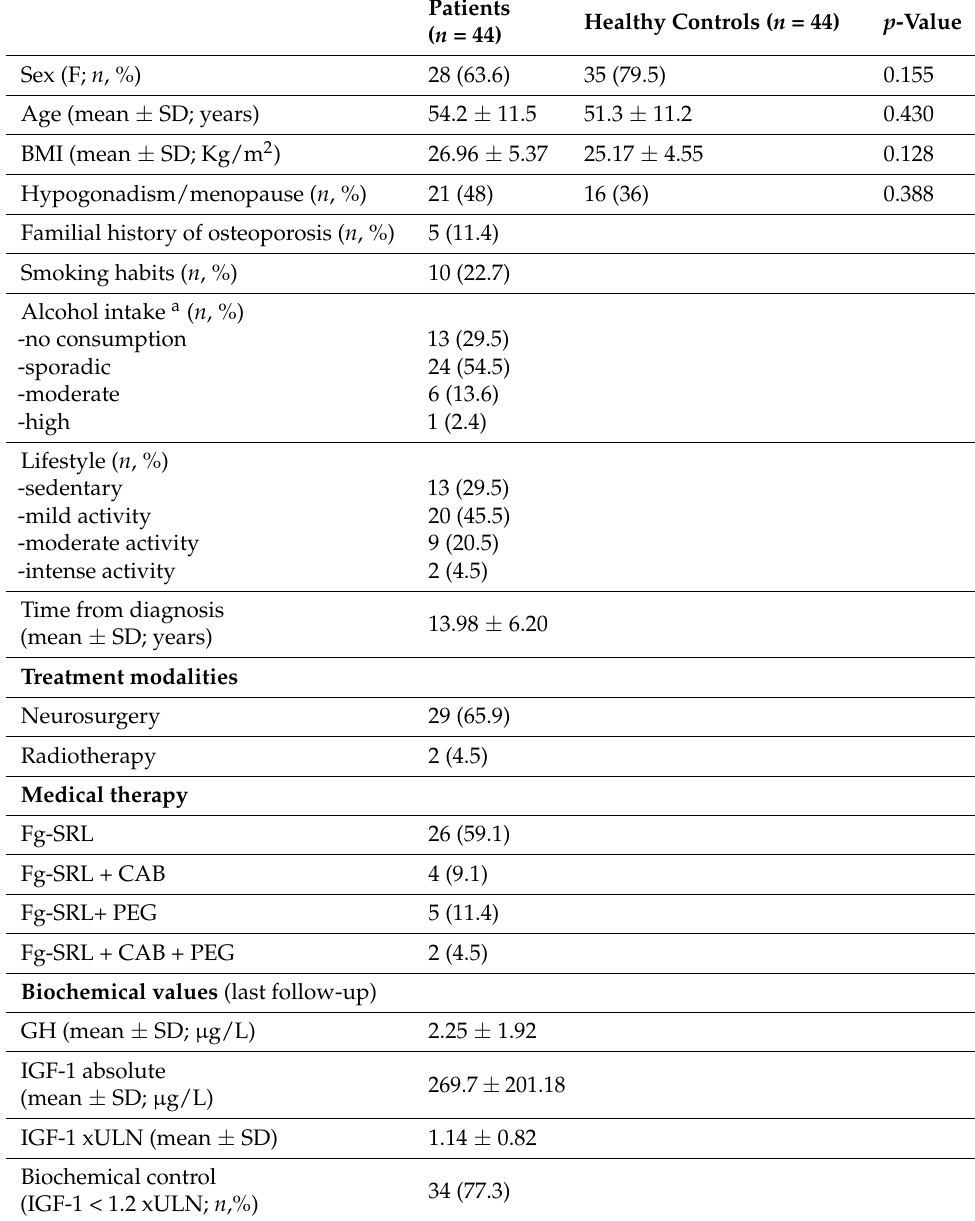
Table 1. General, clinical characteristics and hormone values of the acromegalic patients included in the study. Available data about healthy controls are reported, as well.